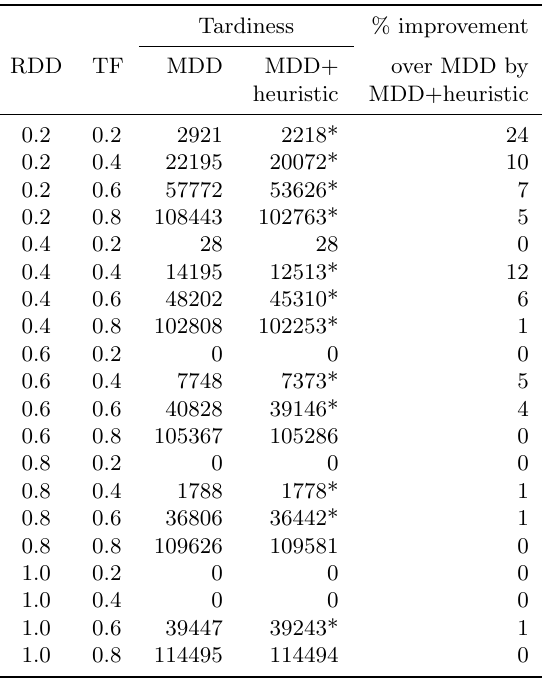
Table 3: Tardiness values obtained for the MDD rule with and without the aid of the heuristic. The results marked with asterisk represent the best performance for the